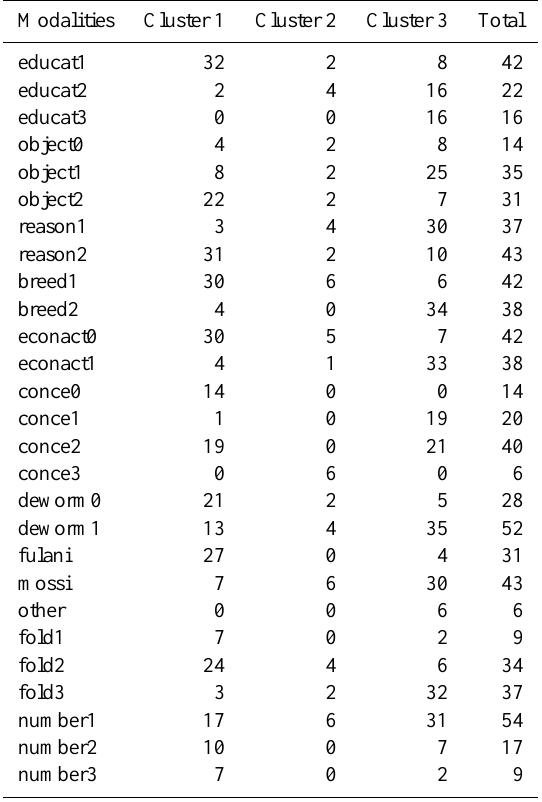
Table 6. Distribution of farmers in the three clusters by